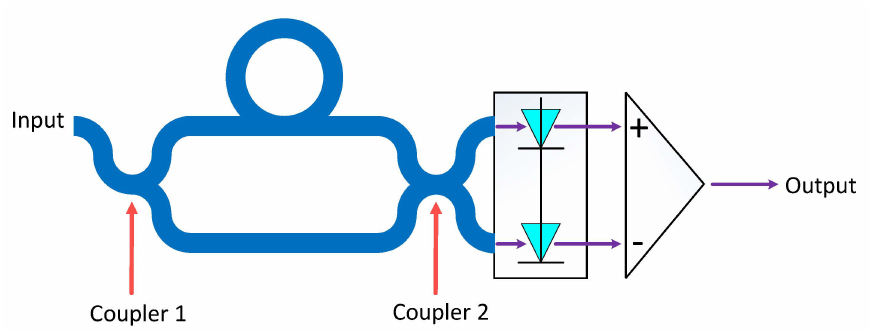
Figure 2. DLI-based